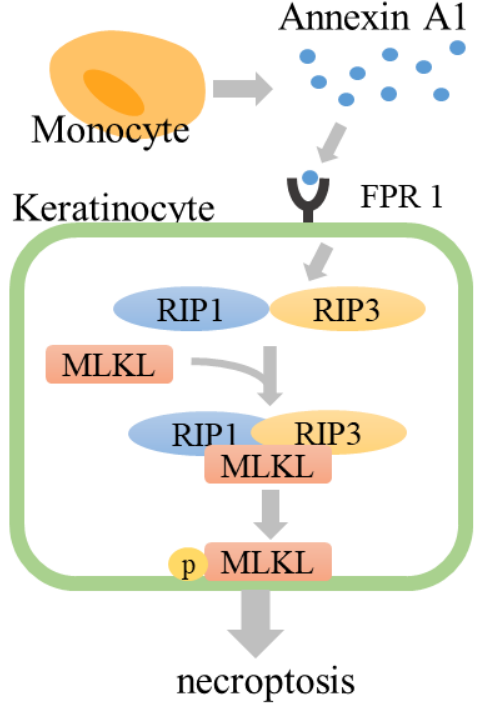
Figure 2. Necroptosis pathway in Stevens-Johnson syndrome/ toxic epidermal necrolysis. Drug-stimulated monocytes secrete annexin A1. Annexin A1 binds to FPR1, RIP1 and RIP3 form the necrosome, and MLKL is phosphorylated by RIP3. Phosphorylated MLKL translocates to the plasma membrane and induces cell death. FPR1, formyl peptide receptor 1; MLKL, mixed lineage kinase domain-like; RIP1, receptor interacting kinase